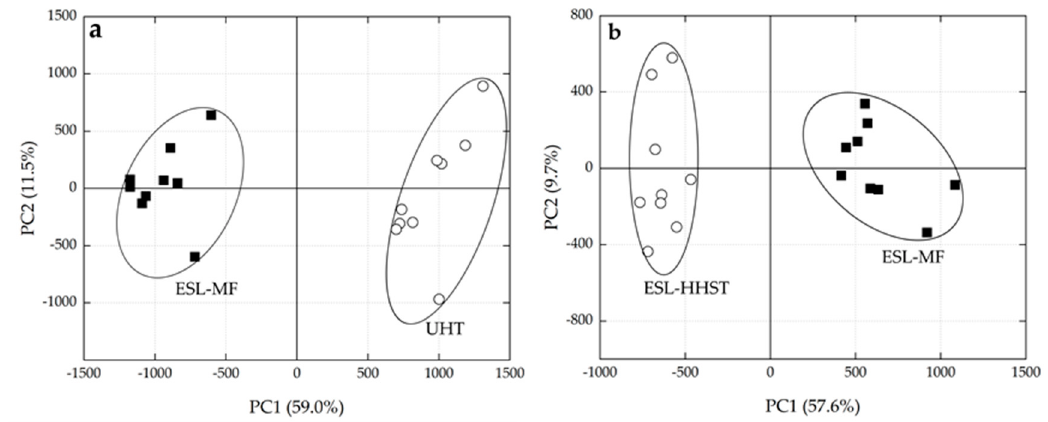
Figure 5. PCA score plot of extended shelf life-microfiltration (ESL-MF) vs. UHT ( a ) and